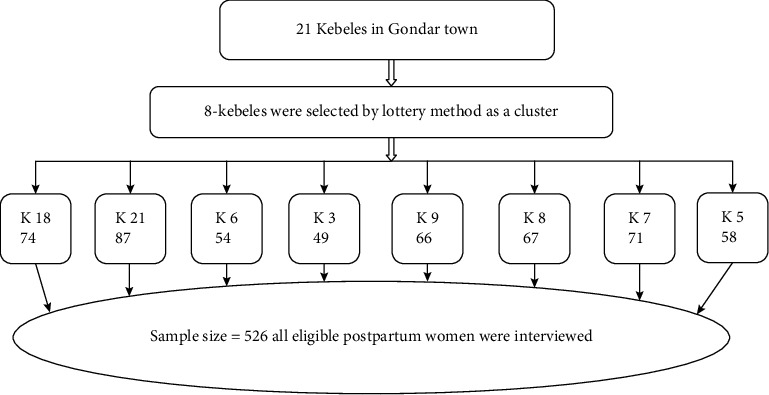
Schematic presentation of sampling procedure to assess prevalence and associated factors of postpartum depression among women who gave birth in the last six weeks at Gondar town, Northwest Ethiopia, 2018 (n = 526).